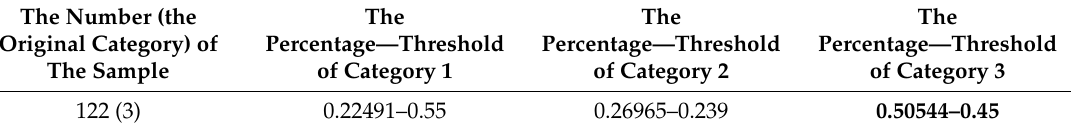
Table 4. The percentage and subtraction of each uncertain Haihe78 corn seed sample.